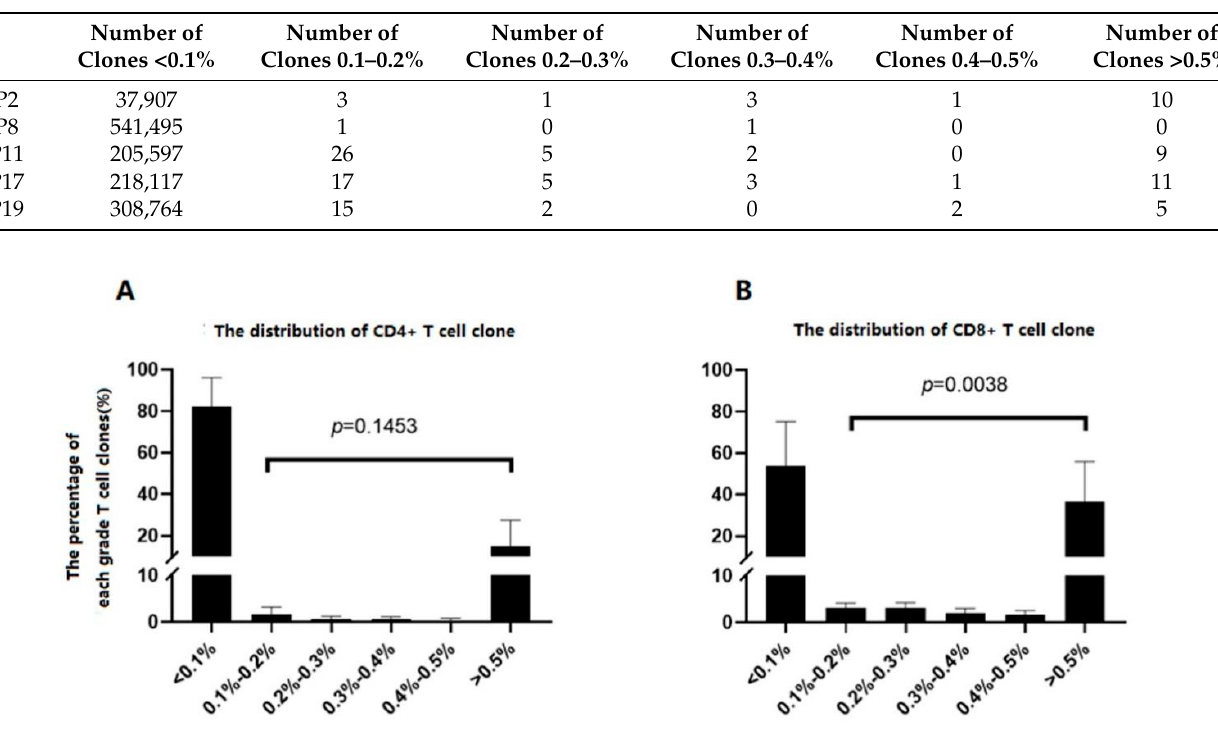
Figure 2. The clone distribution of ITP patients’ CD4 + T and CD8 + T cells before treatment. One Way ANOVA and Kruskal Wallis test were used for data fulfilled normal distribution and for those did not, respectively. ( A ) CD4 + T cell clones; ( B ) CD8 + T cell clones.